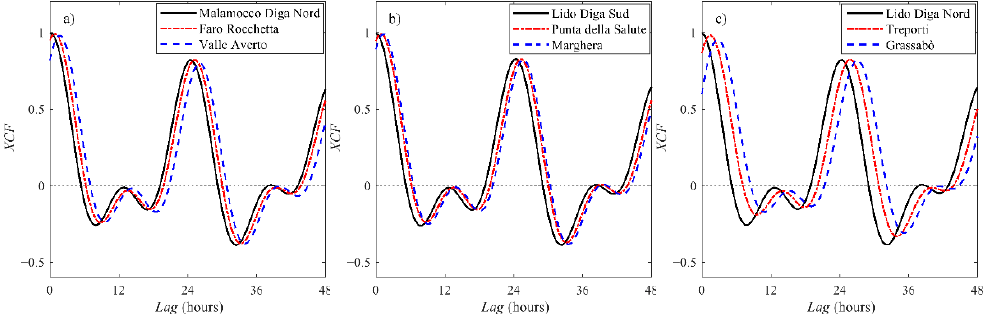
Figure 5. Cross-correlation function between the tide level in Piattaforma CNR and tide level in: Malamocco Diga Nord, Faro Rocchetta and Valle Averto ( a ); Lido Diga Nord, Punta della Salute and Valle Averto ( b ); Lido Diga Sud, Treporti and Grassabò ( c ).